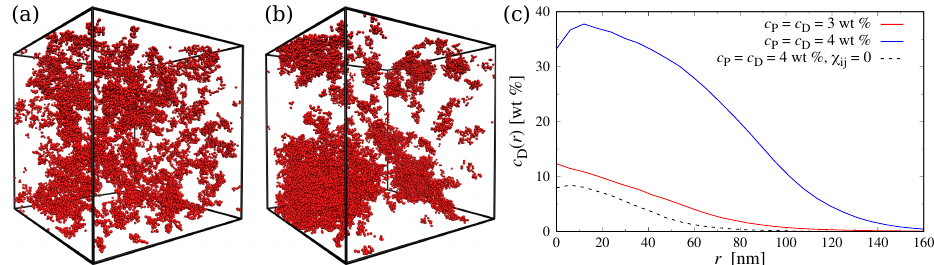
Figure 2. ( a , b ) Simulation snapshot of the bulk system at ( a ) c P = 3wt%, c D = 3wt%, and ( b ) c P = 4wt%, c D = 4wt%. Only Dextran beads shown for clarity. Snapshots rendered using Visual Molecular Dynamics (version 1.9.3) [42]. ( c ) Radial concentration profile of Dextran monomers c D ( r ) in the largest Dextran